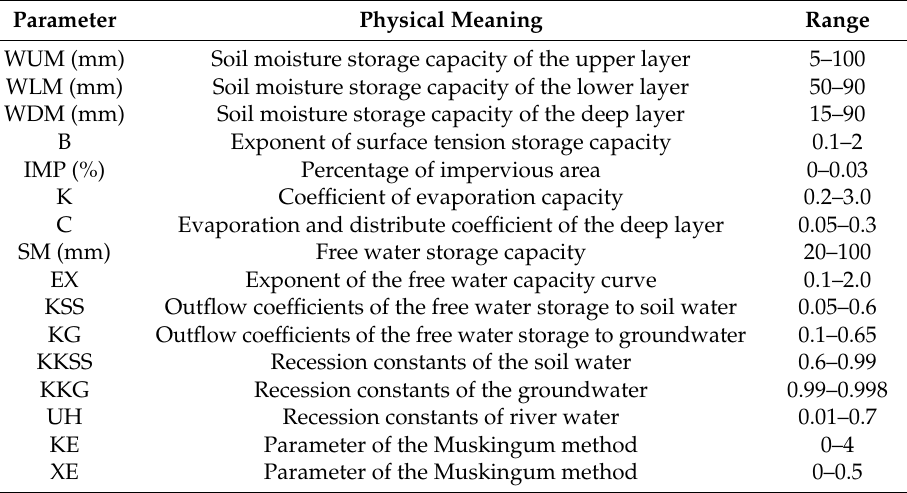
Table 4. Main parameters of the Xinanjiang